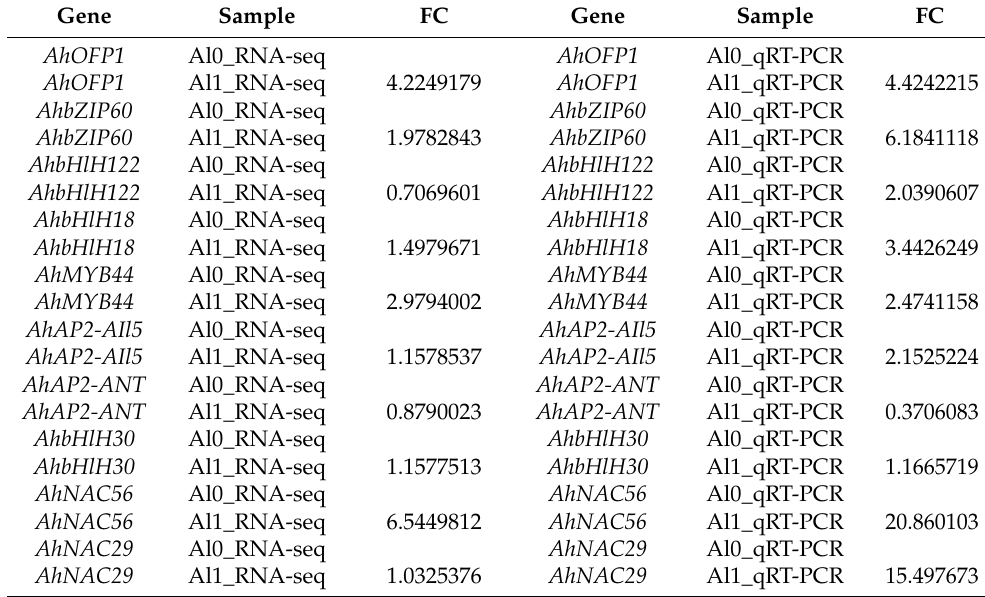
Figure 6. Effect of different Al 3+ concentrations on the regulation of TFs expression. Heatmap of known 38 TFs genes. Red means down-regulation, and blue means up-regulation ( A ). Compare the FPKM value obtained by RNA-seq analysis with the gene relative transcript levels obtained by qRT-PCR analysis ( B ). * means p ≥ 0.05 (LSD). Data were analyzed using the 2 − ∆∆ CT method. Table 4. FC values calculated from randomly selected gene expression and FPKM values obtained by sequencing.